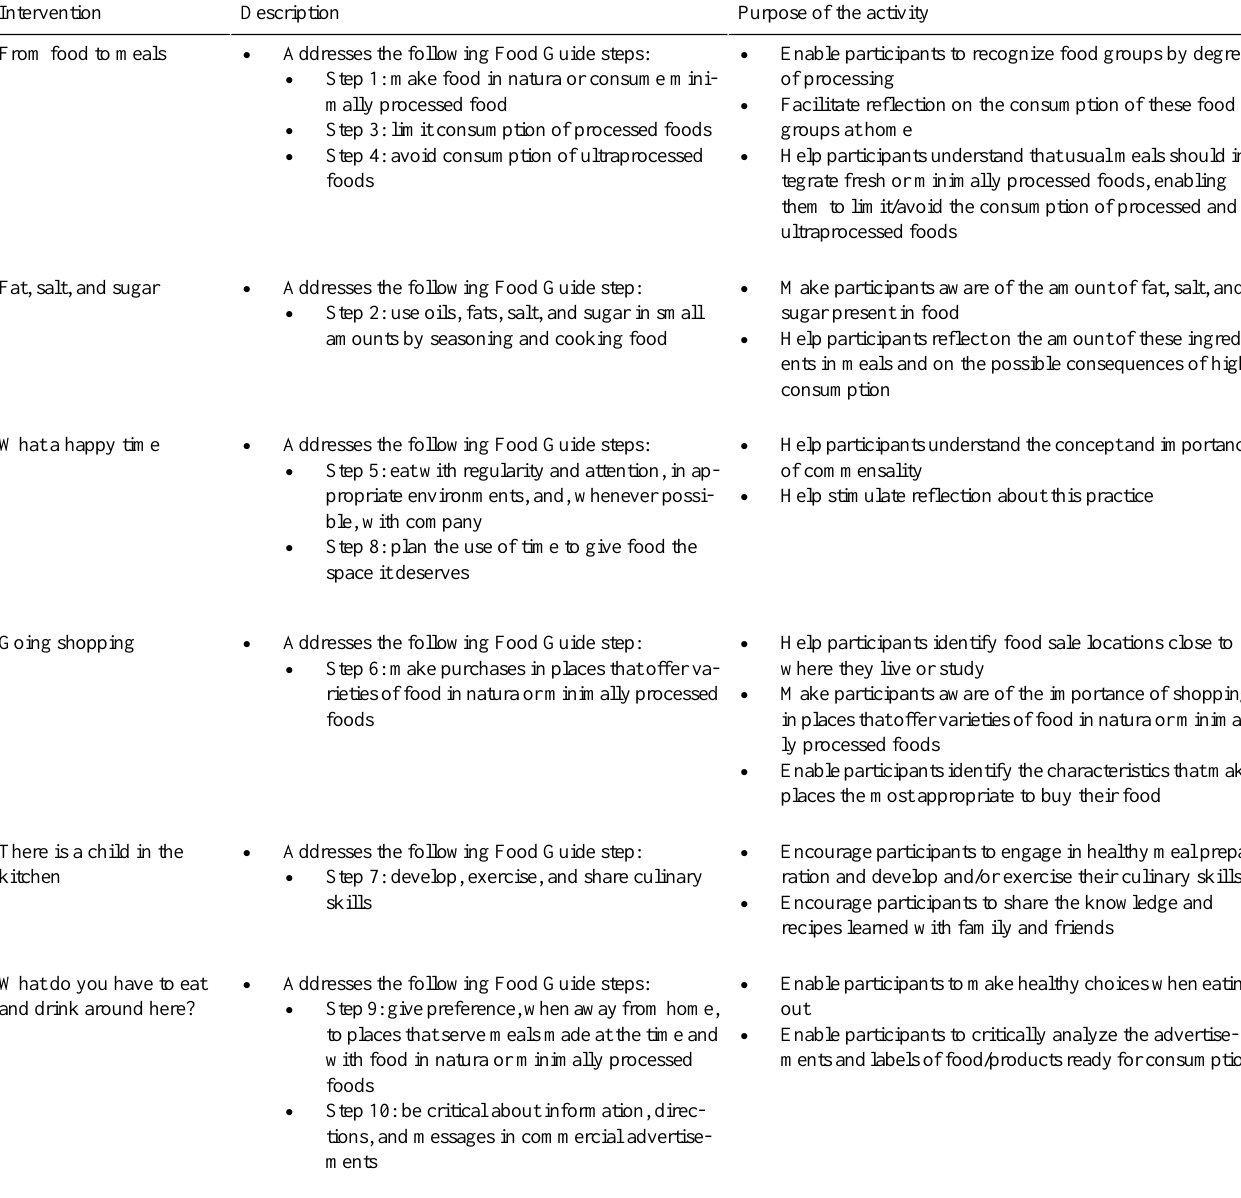
Table 1. Description and objectives of the